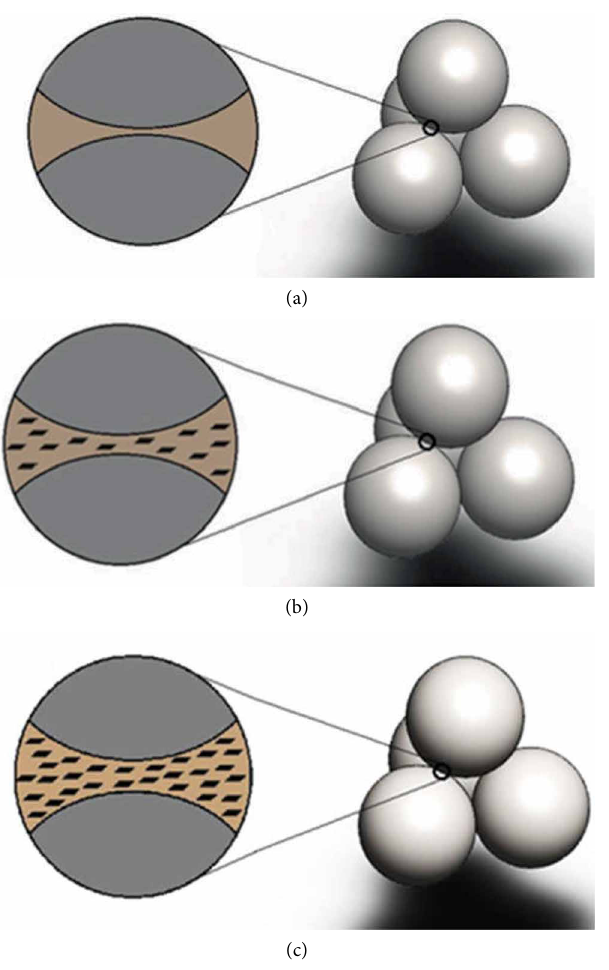
Figure 11: Illustration of formation of thin-film between balls just before the weld: (a) 0.25 wt.% GNPs-NO, (b) 0.50% GNPs-NO, and (c) 1.0% GNPs-NO.